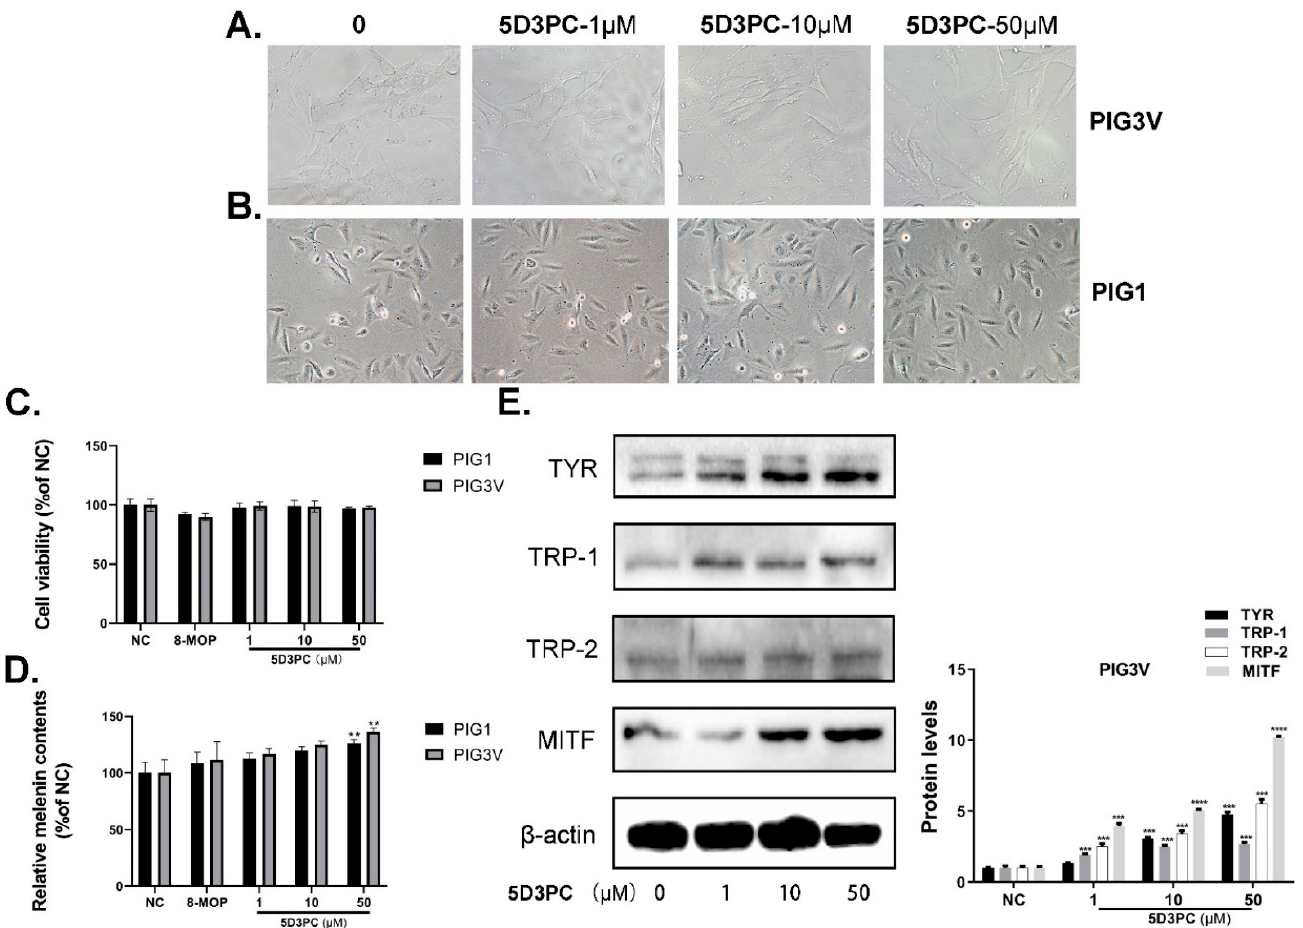
Figure 2. 5D3PC promoted melanogenesis in human melanocytes; PIG1 and PIG3V. ( A , B ) Morphological changes in 5D3PC treated PIG3V cells at 200× magnification. ( C ) Different concentrations (0–50 μ M) of 5D3PC on PIG3V and PIG1 cell viability were measured by CCK-8 assay. ( D ) Effect of 5D3PC on Melanin content of PIG3V and PIG1 melanocytes treated with different concentrations (1, 10, and 50 μ M) of 5D3PC for 48 h. DMSO (0.1%) was used as the vehicle control, and 8-MOP (100 µ M) as the positive control. ( E ) The expression of melanogenic genes in PIG3V cells treated with different concentrations (0–50 µ M) of 5D3PC. All results are expressed as mean ± SD; statistical analysis was performed with one-way ANOVA, followed by Tukey’s multiple comparisons test. ** p < 0.01, *** p < 0.001 and **** p < 0.0001 compared with NC (negative control)